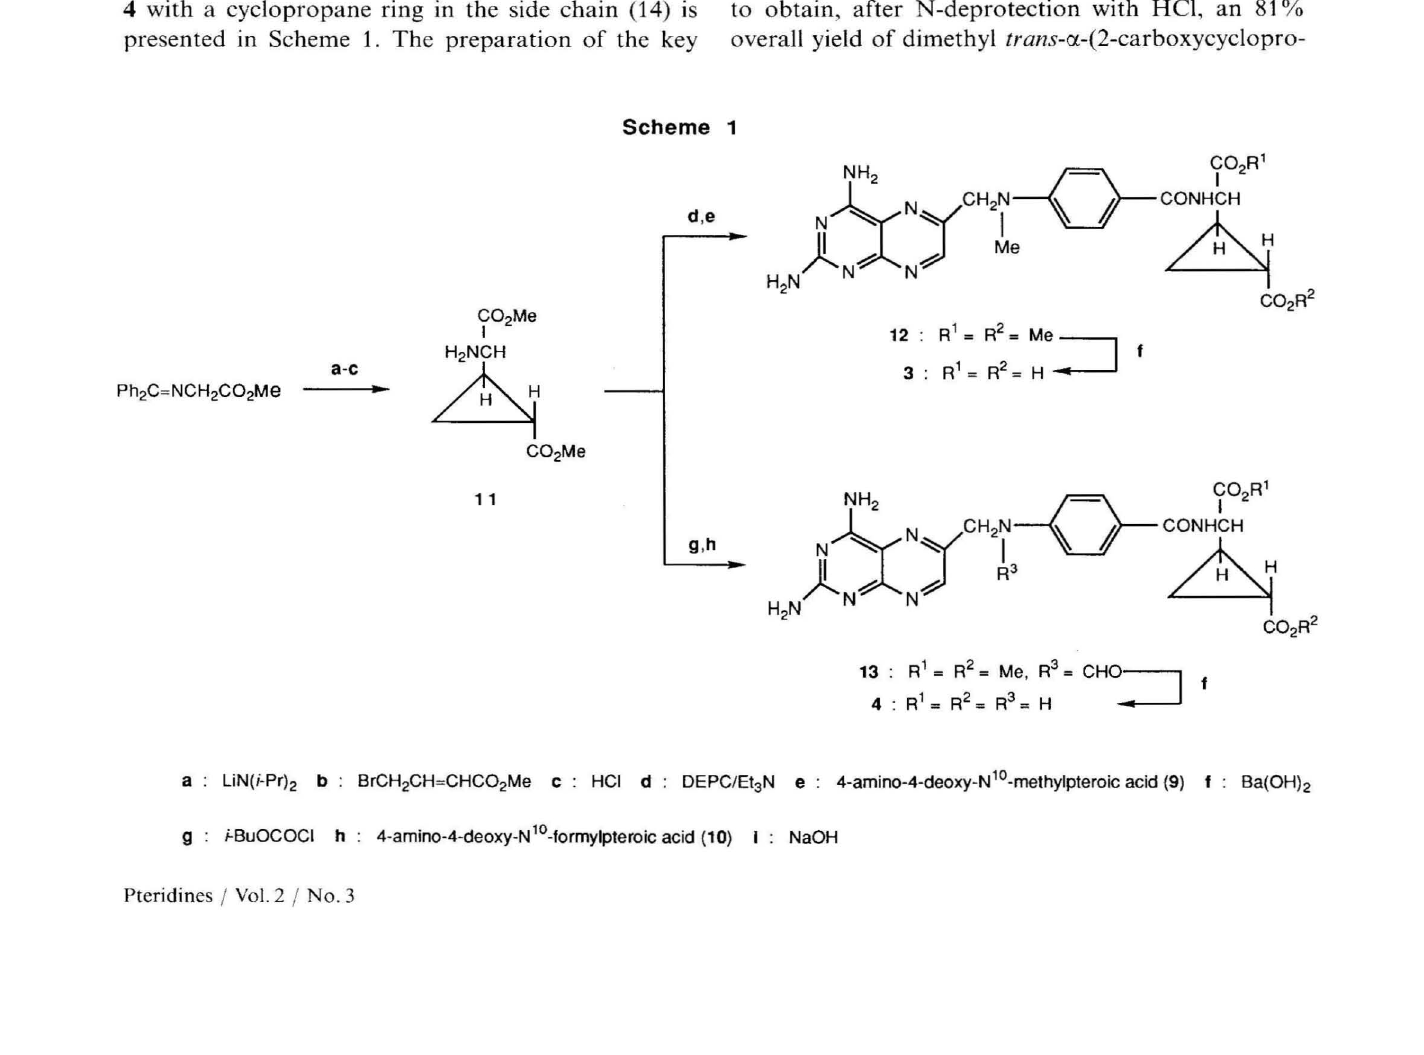
7 and 8, which we have previously shown to have antifolate activity similar to MTX (6a). The structural relationships among compounds 1-8 are evident in Figure